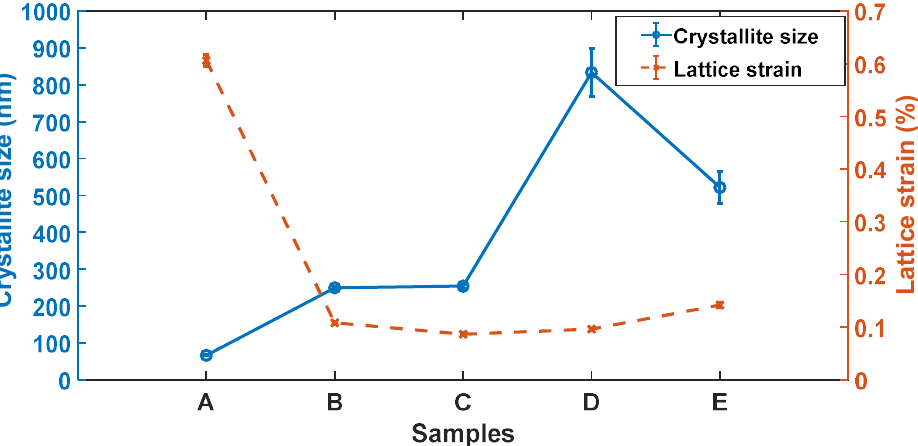
Figure 8. Comparative trend of average crystallite size and lattice strain for various samples of DMLS Ti6Al4V (ELI) as determined by the Rietveld refinement method.